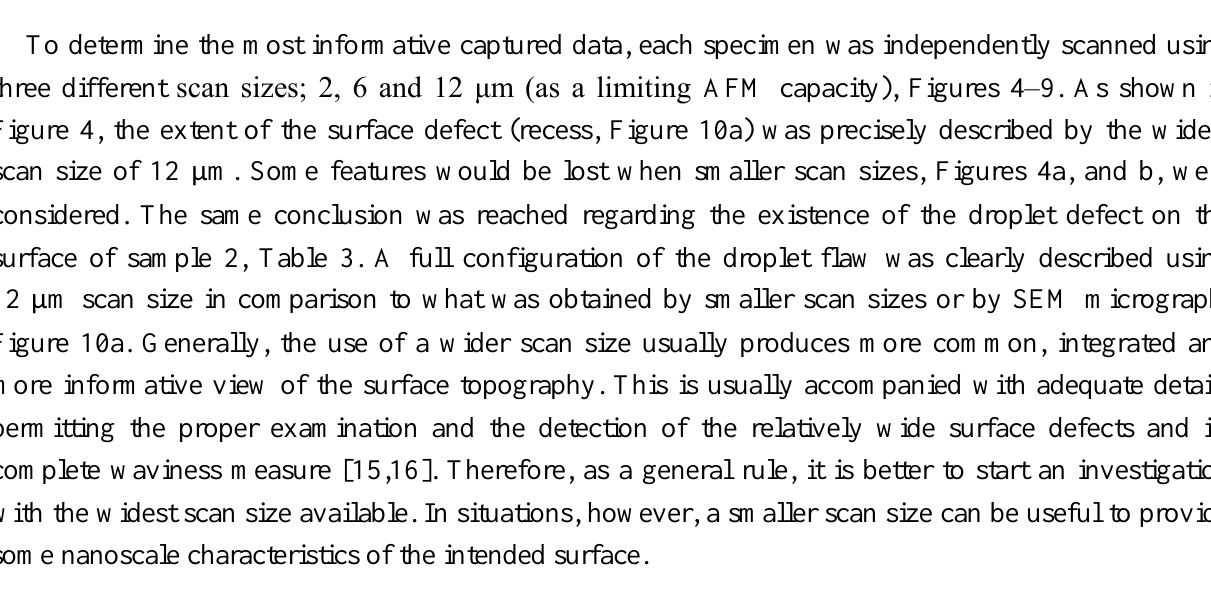
Figure 7. Three dimensional Height images for different scan sizes for GC435 coated carbide inserts of (a) 2 μm; (b) 6 μm and (c) 12